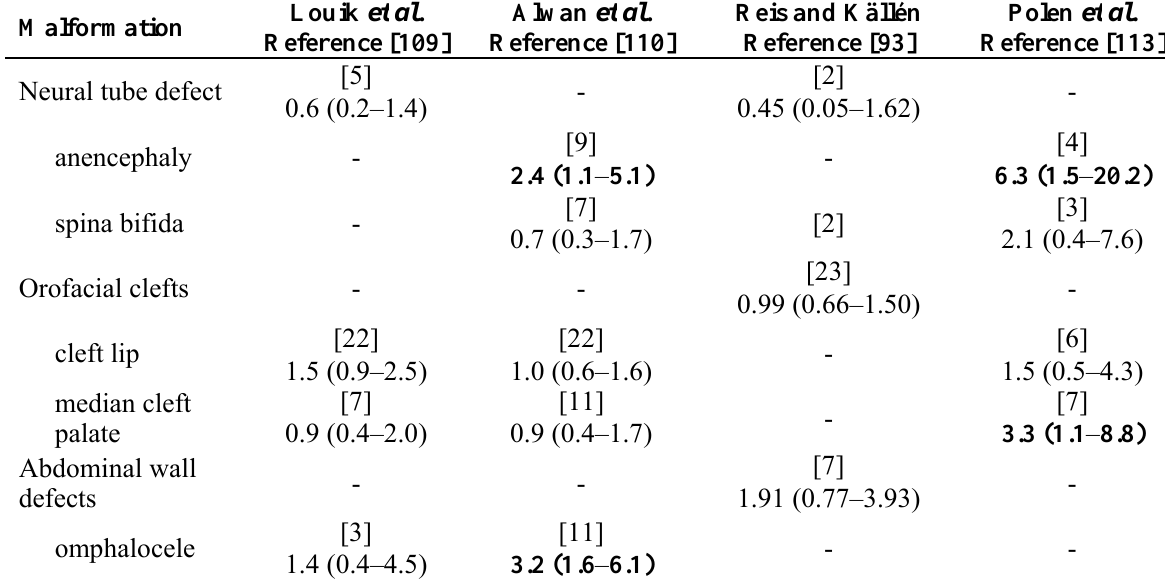
Table 32. Publications with information on other congenital malformations than cardiovacular defects after maternal use of antidepressants. Numbers within [] show the number of exposed specific malformations. Bold text marks statistical